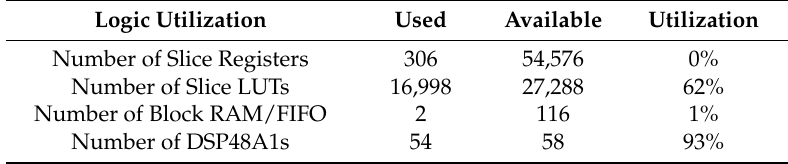
Table 3. Device utilization summary of the PID controller on a Xilinx Zynq FPGA device